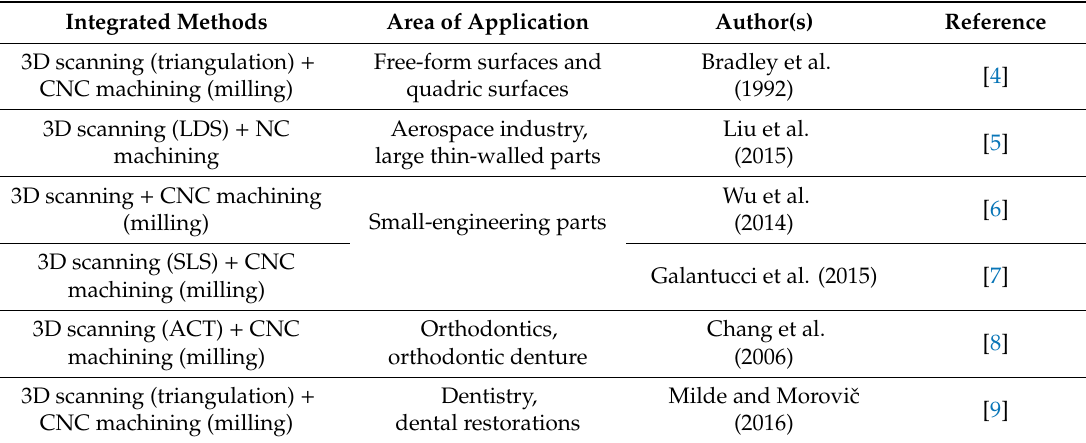
Table 1. Integrated machining systems and their fields of application. Integrated